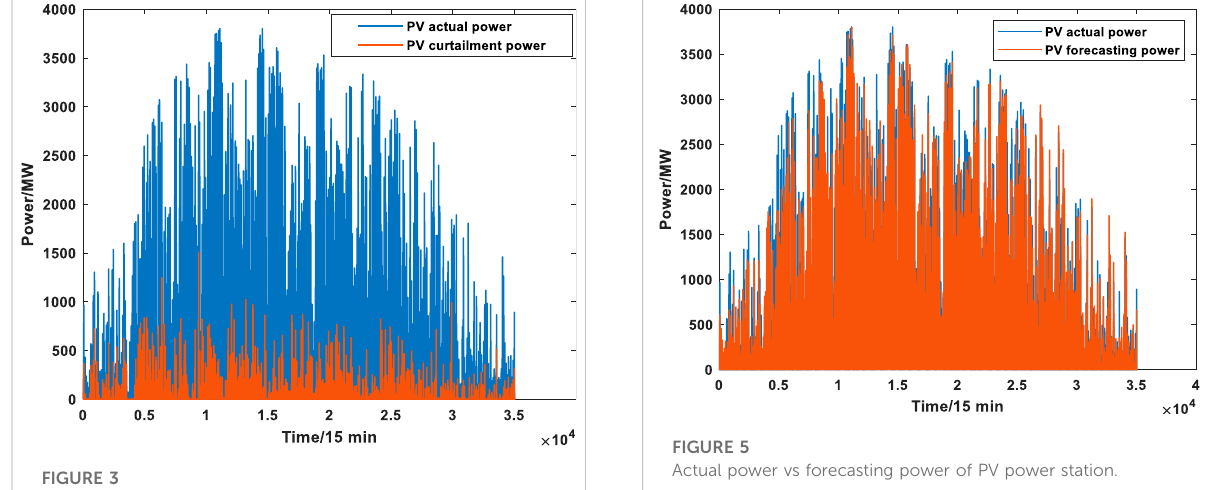
FIGURE 3 Actual power and curtailment power of PV plant in a whole year.